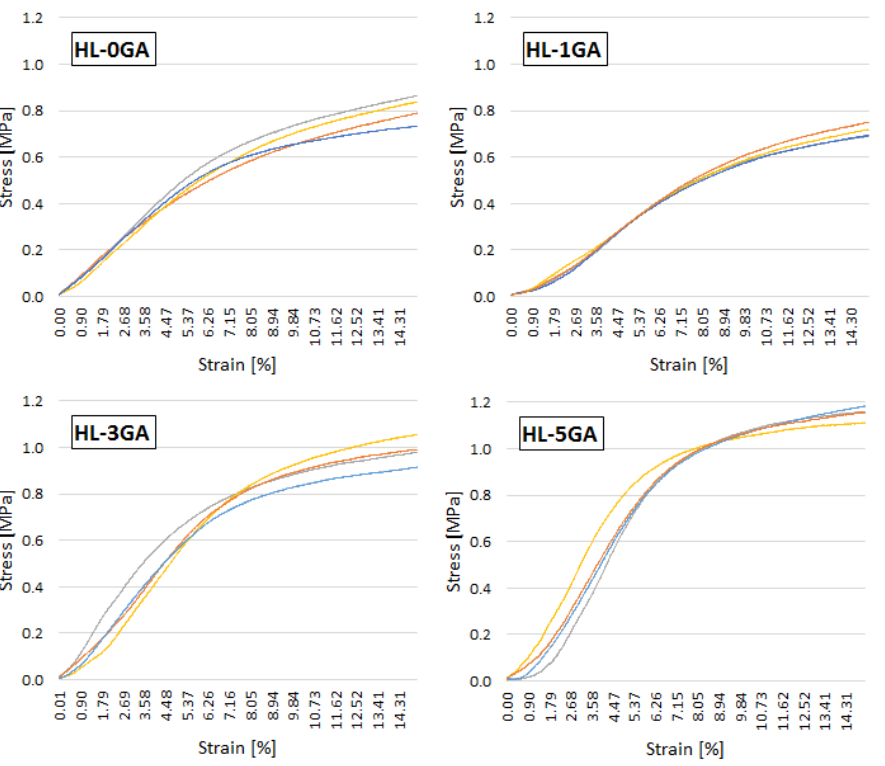
Figure 13. Stress – strain relationship of tested hemp-lime composites. Figure 13. Stress–strain relationship of tested hemp-lime composites.